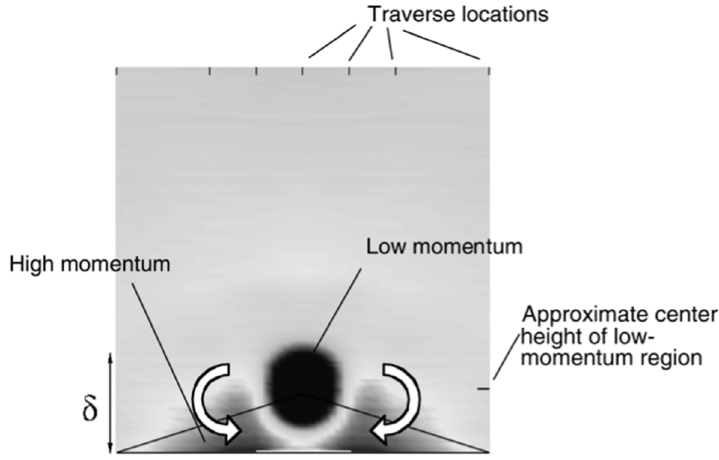
Fig. 13 The momentum variation between the baseline velocity profile and ramp flow